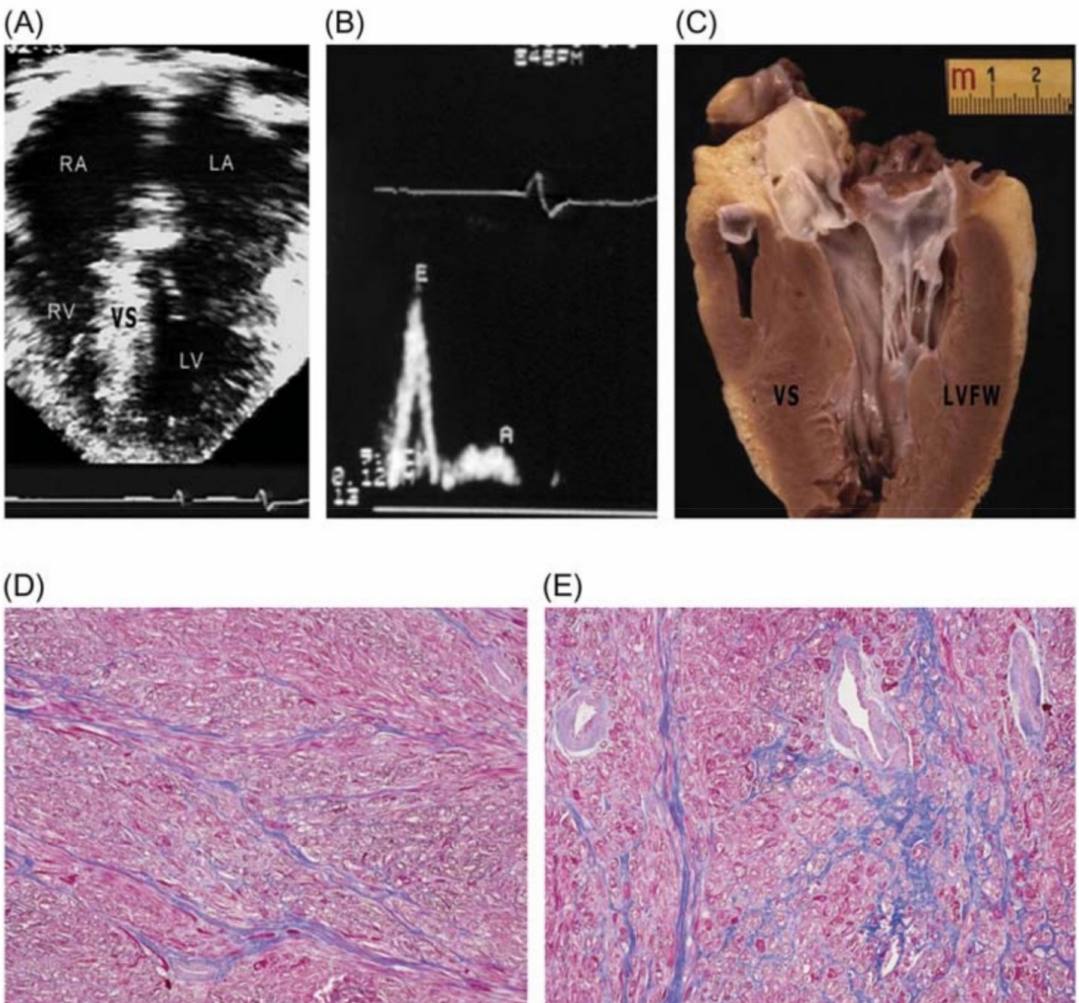
Figure 1. Restrictive form of heart failure due to diastolic dysfunction in a 28-year-old patient with non-obstructive hypertrophic cardiomyopathy preserved systolic function and troponin I variant. ( A ) Four-chamber view in end-diastole showing dilatation of both atria (left atrium, LA = 53 mm), normal-sized ventricles, and mild ventricular septal (VS) thickening (17 mm). ( B ) Pulsed Doppler waveform with evidence of restrictive filling: E/A>2; deceleration time, 150 ms. ( C ) Long-axis left ventricular (LV) plane with mild VS hypertrophy (17 mm); atria missing due to transplantation. ( D , E ) LV free wall ( D ) and septum ( E ) showing diffuse myocardial disarray, mild interstitial fibrosis, and intramural small vessel disease. Trichrome stain × 40. LVFW: left ventricular free wall; RA: right atrium; RV: right ventricle. Reproduced with permission from